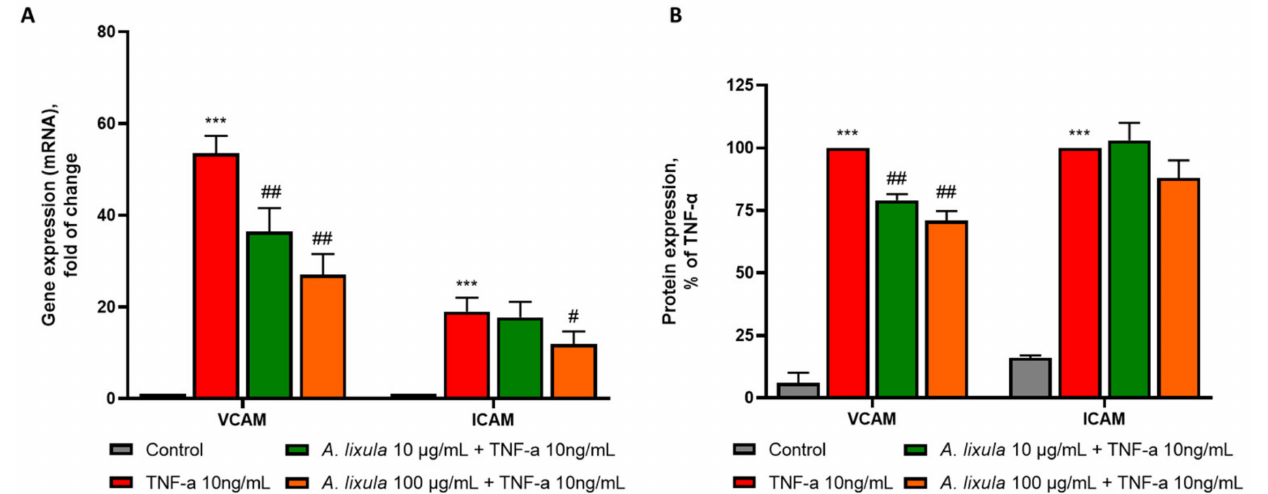
Figure 3. Effect of A. lixula extract on TNF- α -induced expression of endothelial adhesion molecules. HMEC-1 were treated with A. lixula extract for 4 h at the concentration indicated, and then either treated with 10 ng/mL TNF- α or left untreated for 18 h. ( A ) mRNA levels of VCAM-1 and ICAM-1 were measured by qPCR. Data (means ± S.D., n = 3) are expressed as fold induction over basal (untreated) control. *** p < 0.001 vs. basal (untreated) control; # p < 0.05 vs. TNF- α alone; ## p < 0.01 vs. TNF- α alone. ( B ) Endothelial cell surface protein expression of VCAM-1 and ICAM-1 was assessed by EIA and expressed as percent of TNF- α . *** p < 0.001 vs. basal (untreated) control; ## p < 0.01 vs. TNF- α